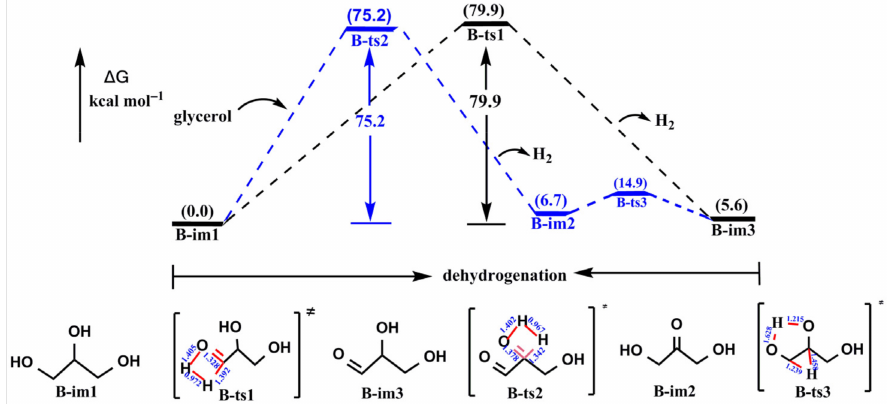
Figure 1. Energy profile for the background reaction of glycerol to